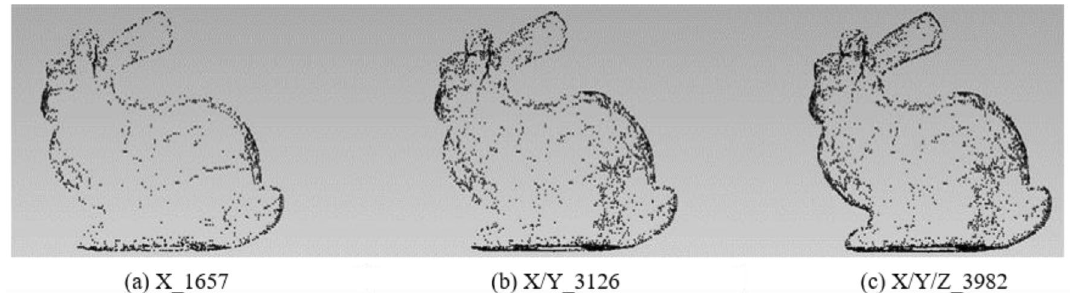
Figure 2. The point cloud with different numbers of feature points extracted with different axes for Bunny.